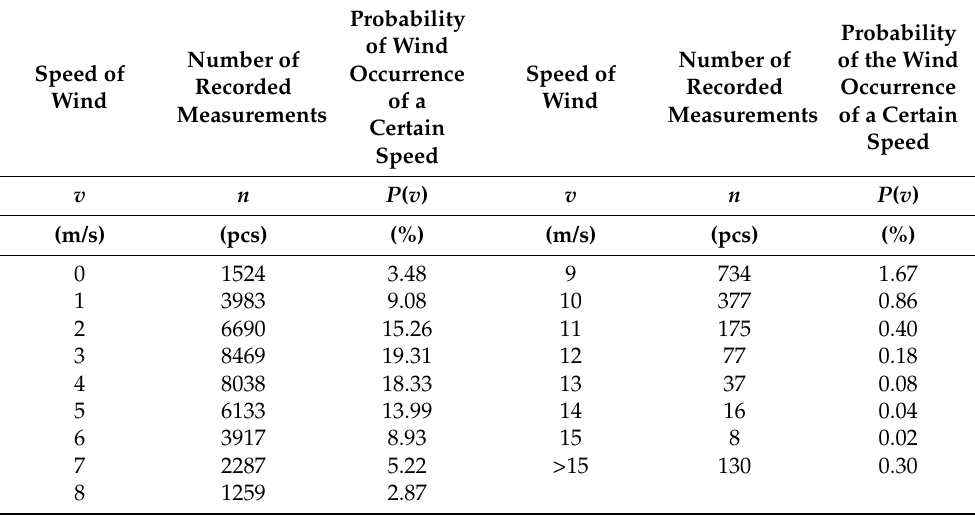
Figure 3. The probability of the wind appearance of a certain speed in the RBG’s area (according to [75], based on [77]).